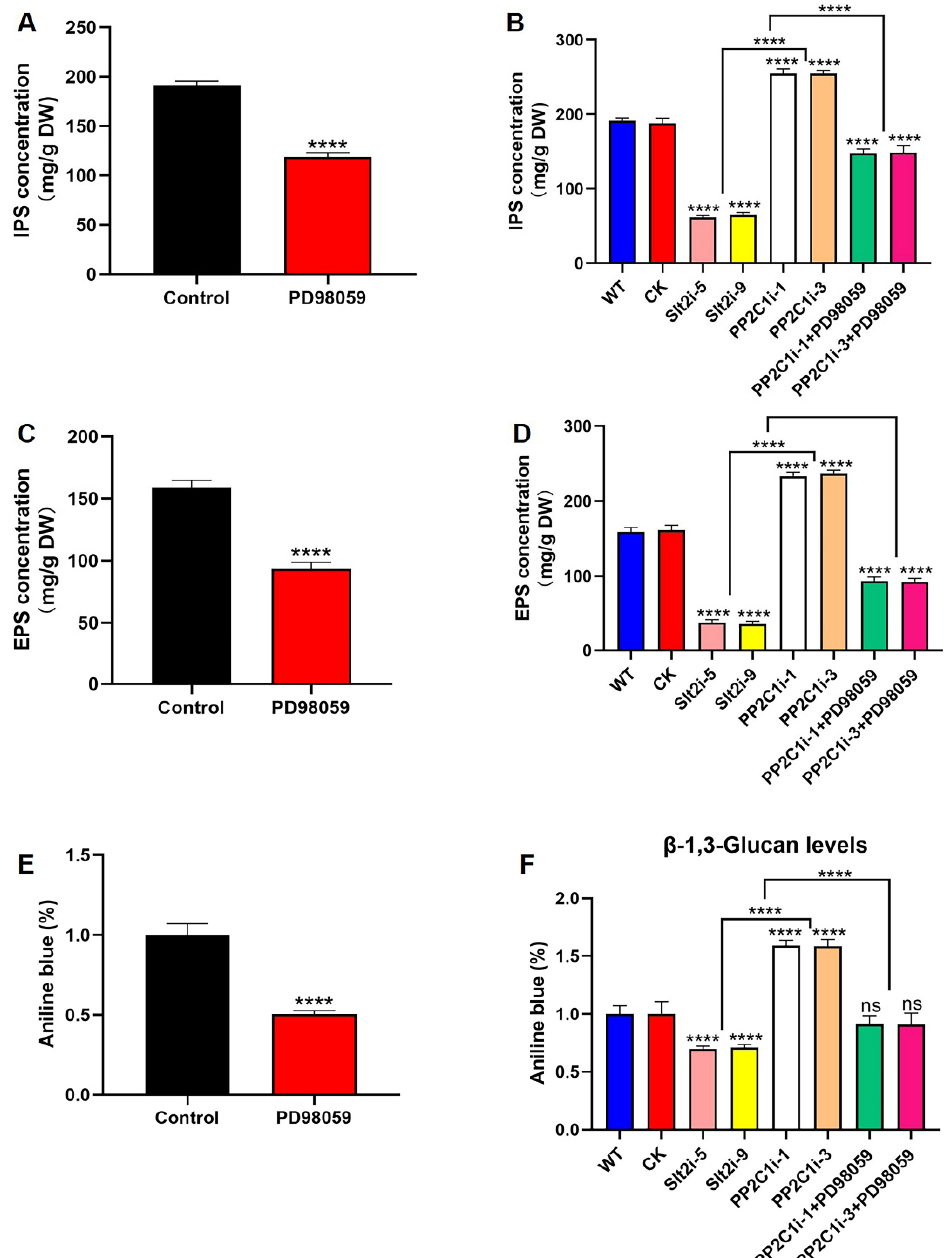
Figure 5. GL-PS content. ( A ) IPS contents in WT strains treated or not treated with 20 µ M PD98059. ( B ) IPS contents in WT, CK, Slt2-silenced and PP2C-silenced strains treated with 20 µ M PD98059. ( C ) EPS contents in WT strains treated or not treated with 20 µ M PD98059. ( D ) EPS contents in WT, CK, Slt2-silenced and PP2C-silenced strains treated with 20 µ M PD98059. ( E ) β -1,3-D-glucan content in WT strains treated or not treated with 20 µ M PD98059. ( F ) β -1,3-D-glucan content in WT, CK, Slt2-silenced and PP2C-silenced strains treated with 20 µ M PD98059. The data are presented as the means ± SDs from three independent experiments (**** p < 0.0001 by one-way ANOVA).